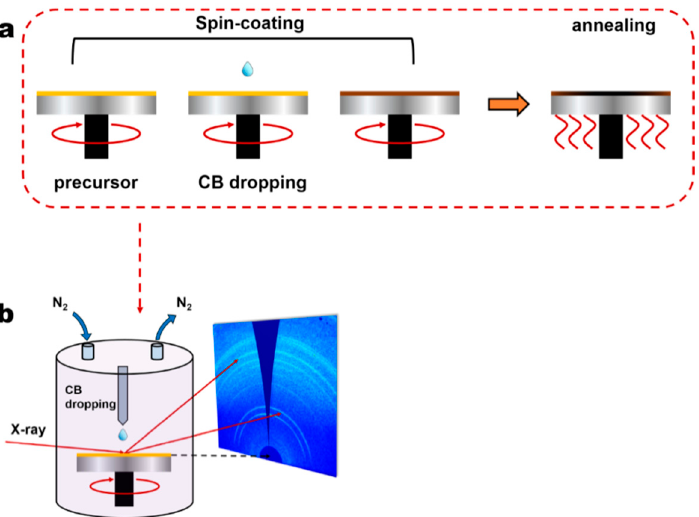
Figure 1. Schematics of the film fabrication procedure and the experimental setup for in situ GIWAXS measurement. ( a ) The steps of perovskite fabrication process and ( b ) The in situ GIWAXS experimental setup equipped with a spin coater, heating platform, and an antisolvent syringe under nitrogen environment.